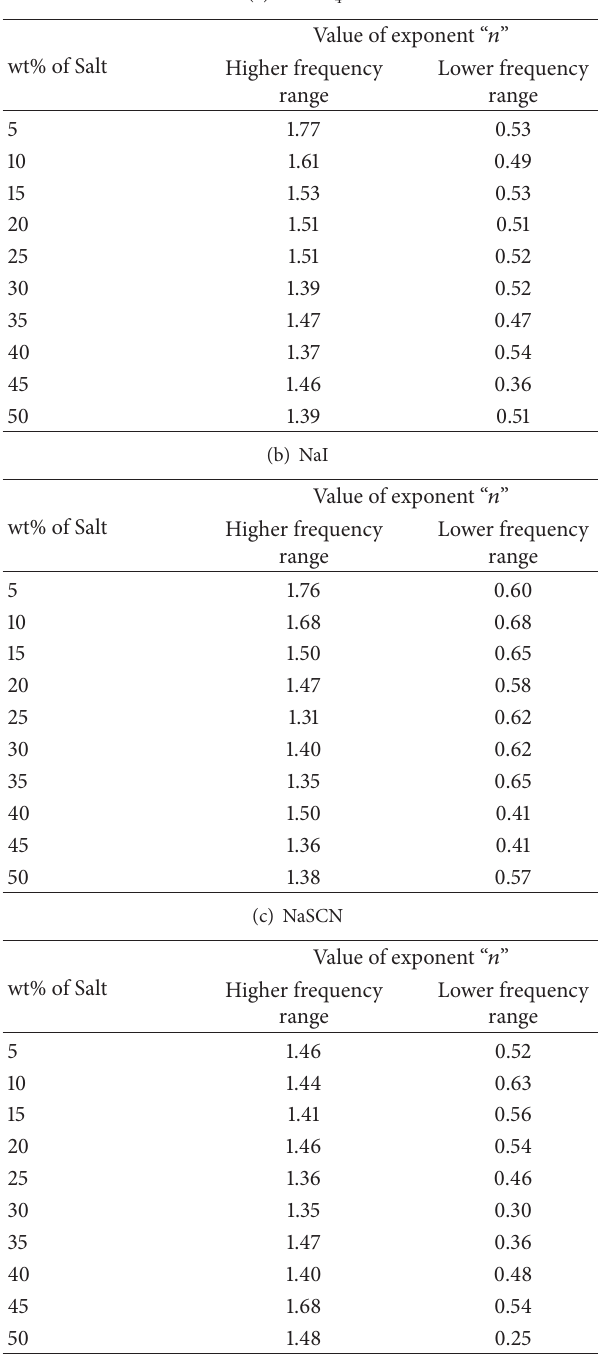
Table 3: Values of exponent “ 𝑛 ” in different frequencies (Ion hopping and SLPL) range for (a) NaClO containing systems.